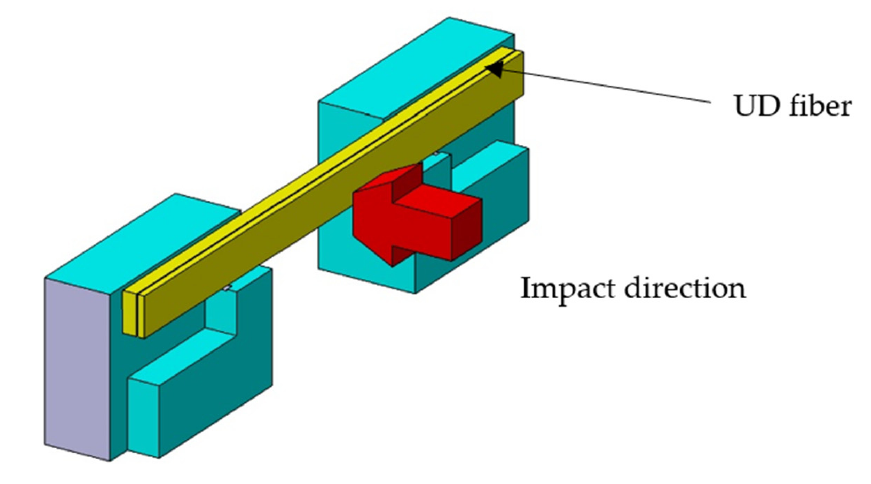
Figure 5. Impact test configuration.